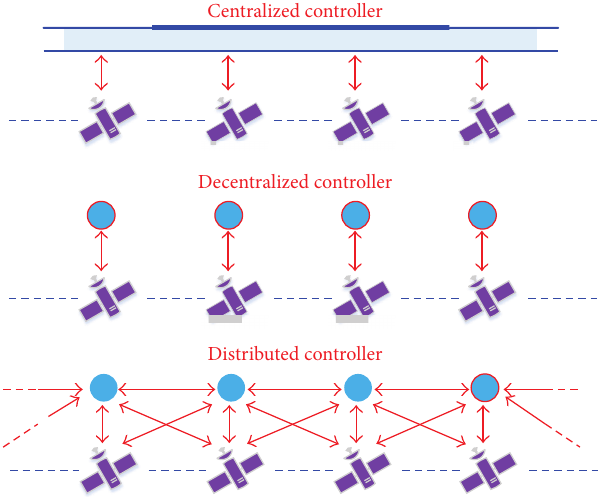
Figure 1: Three kinds of control strategies [8].